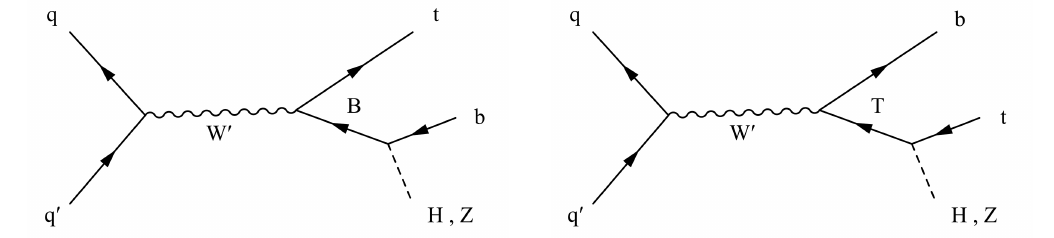
Figure 1 . Dominant Feynman diagrams for the signal model